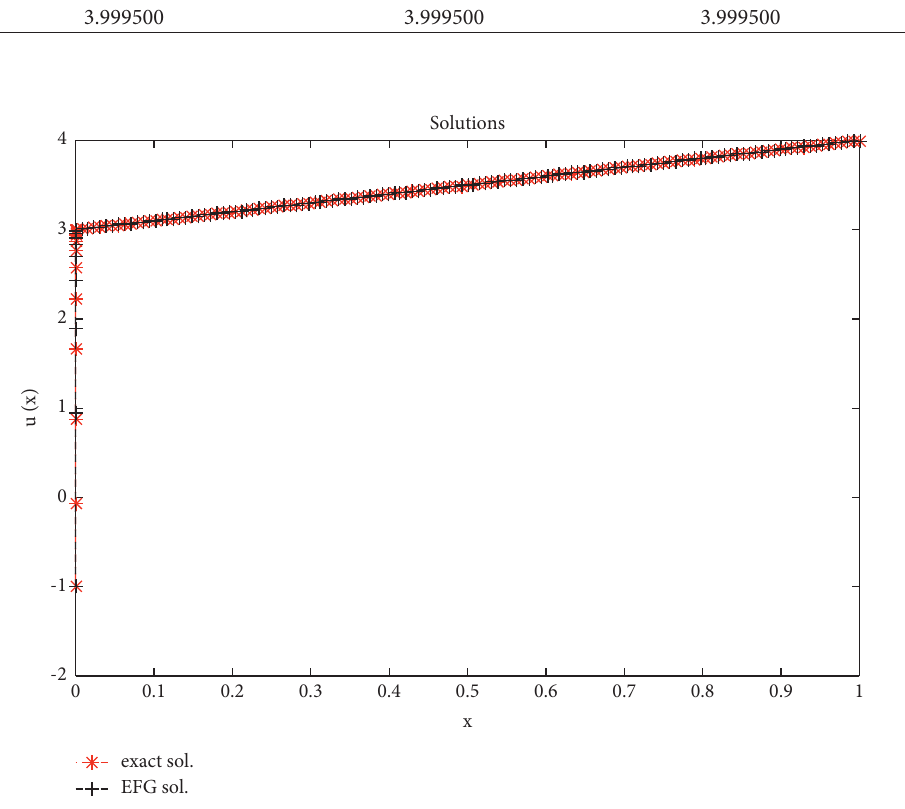
Figure 7: Exact and EFG solution plot for ϵ � 10 − 5 and N � 256 for Example